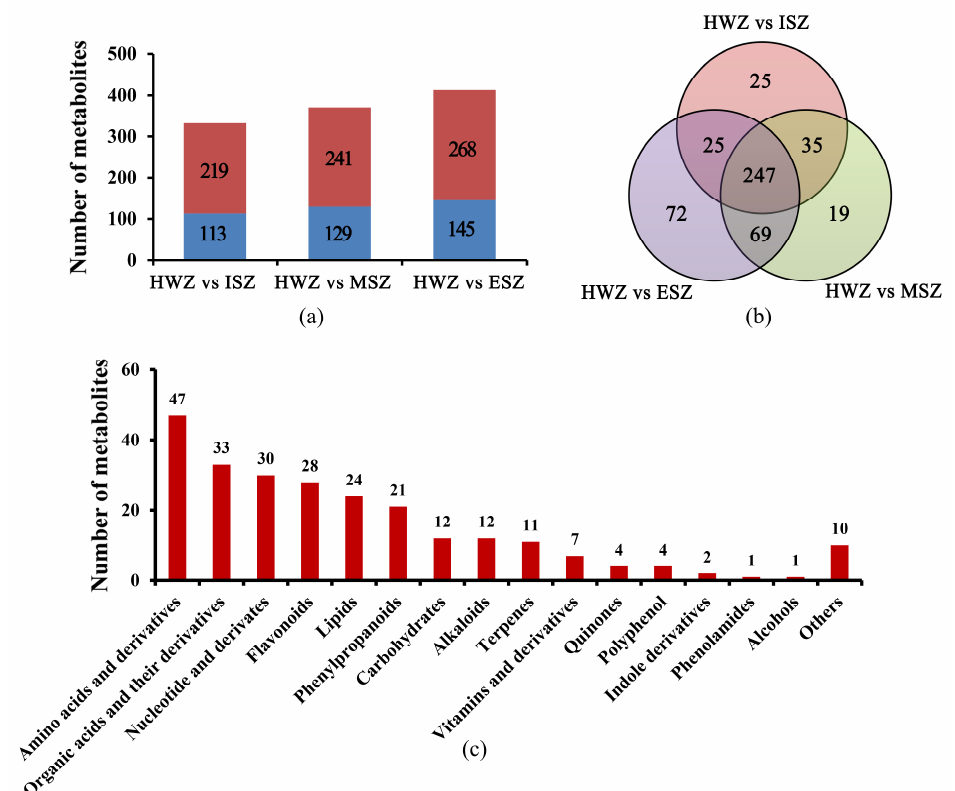
Figure 4. The di ff erential metabolites analysis. ( a ) The number of di ff erential metabolites between ISZ, MSZ, ESZ, and HWZ, respectively. Red pillars represent up-regulated di ff erentially expressed metabolites; Blue pillars represent down-regulated di ff erentially expressed metabolites. ( b ) The Venn diagram of di ff erential metabolites of the comparison groups HWZ vs. ISZ, HWZ vs. MSZ, and HWZ vs. ESZ, respectively. ( c ) Number of di ff erent types of di ff erential metabolites.